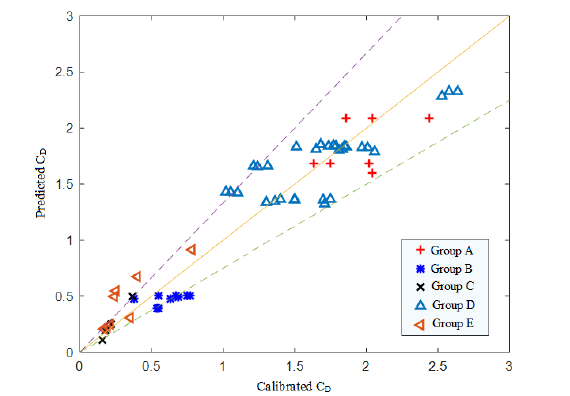
Figure 9. The predicted drag coefficient, C D , by the explicit Formula (6) vs. the numerically calibrated C D for all 60 cases. The coefficient of determination is R 2 = 0.91. Dashed lines indicate the 25% bounds. See Table 1 for the conditions of each Group.